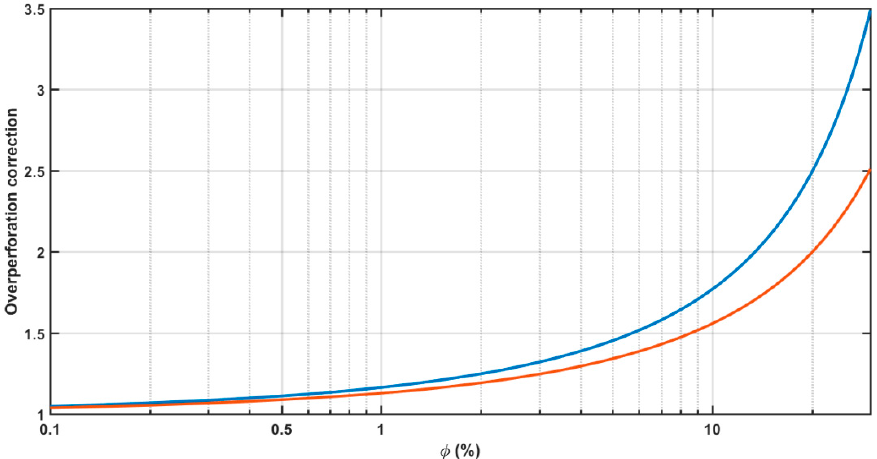
Figure 12. Overperforation correction factors by Fok function and tortuosity.